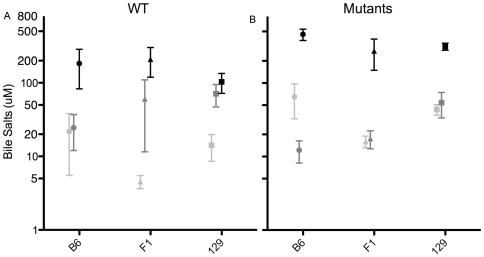
Serum Bile salts levels are higher in ATP8B1 mutant mice.Serum bile salt levels in WT (A) and Atp8b1 mutant (B) mice of B6, 129, and F1 backgrounds at baseline (light grey) and after feeding of cholate (black) or control (medium grey) diet for 4–8 days; means and SEM are shown. N's at baseline: B6 (n = 9−15), 129 (n = 48−43), and F1 (n = 43−45). N's for cholate diet: B6 (n = 7−13), 129 (n = 18−35), and F1 (n = 13−18); and control diet: B6 (n = 5−9), 129 (n = 22−29), and F1 (n = 11−16).